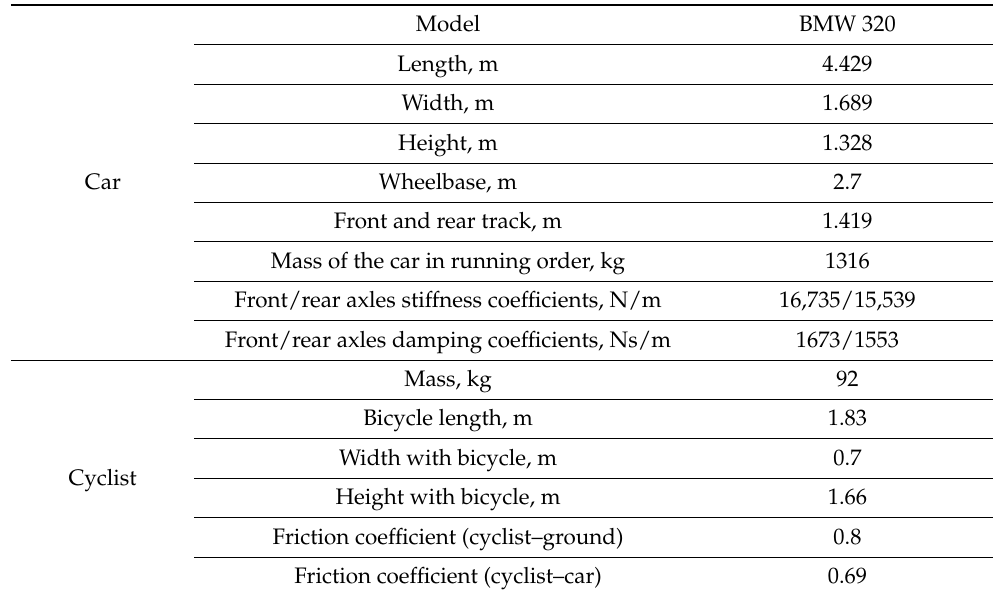
Table 1. Car and cyclist